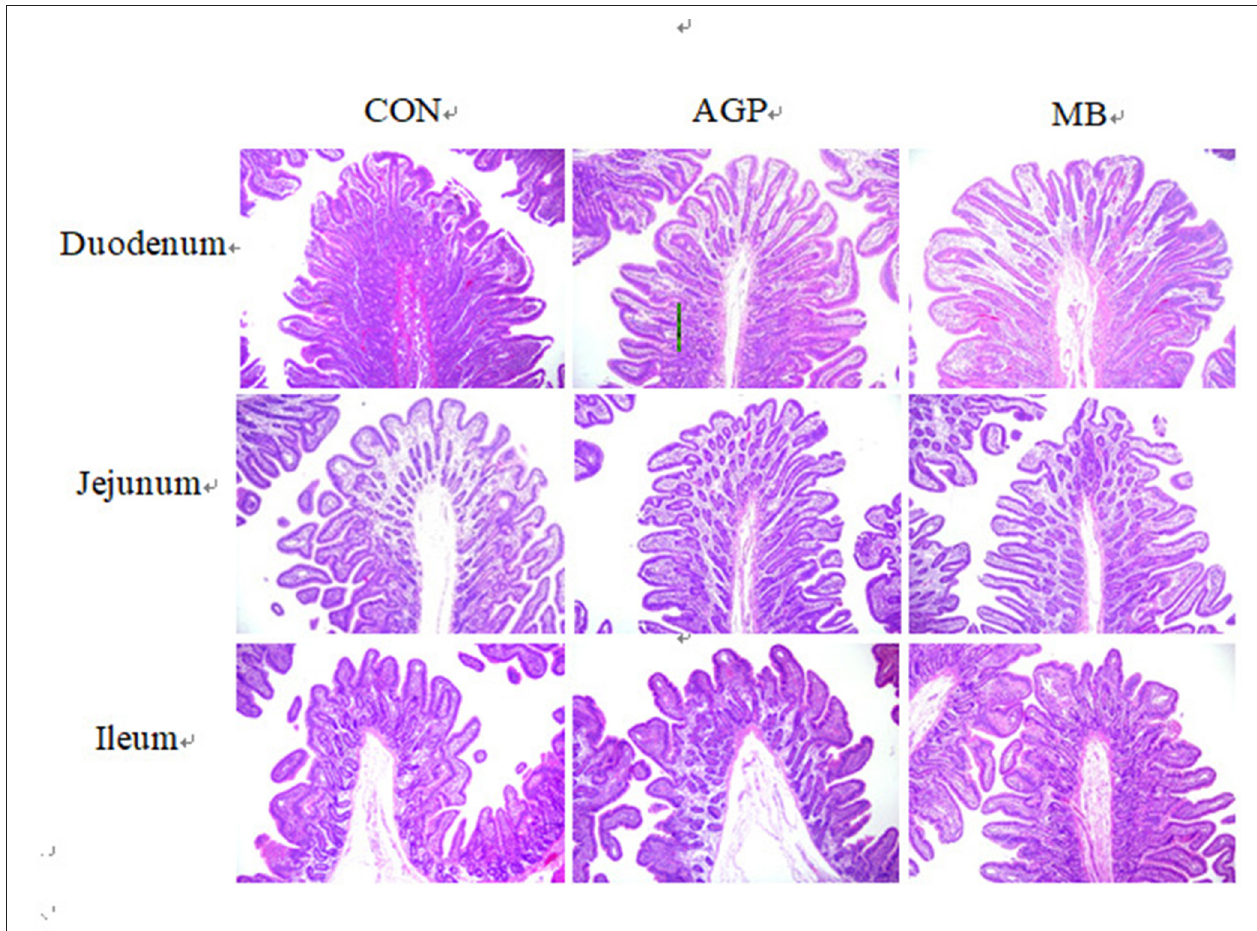
FIGURE 2 | Detection of small intestine morphology of weaned piglets [H&E, 40X]. CON, basal diet; AGP, basal diet + 20 mg/kg flavomycin + 50 mg/kg quinocetone; MB, basal diet + 50 mg/kg Macleaya cordata extract + 1,000 mg/kg benzoic